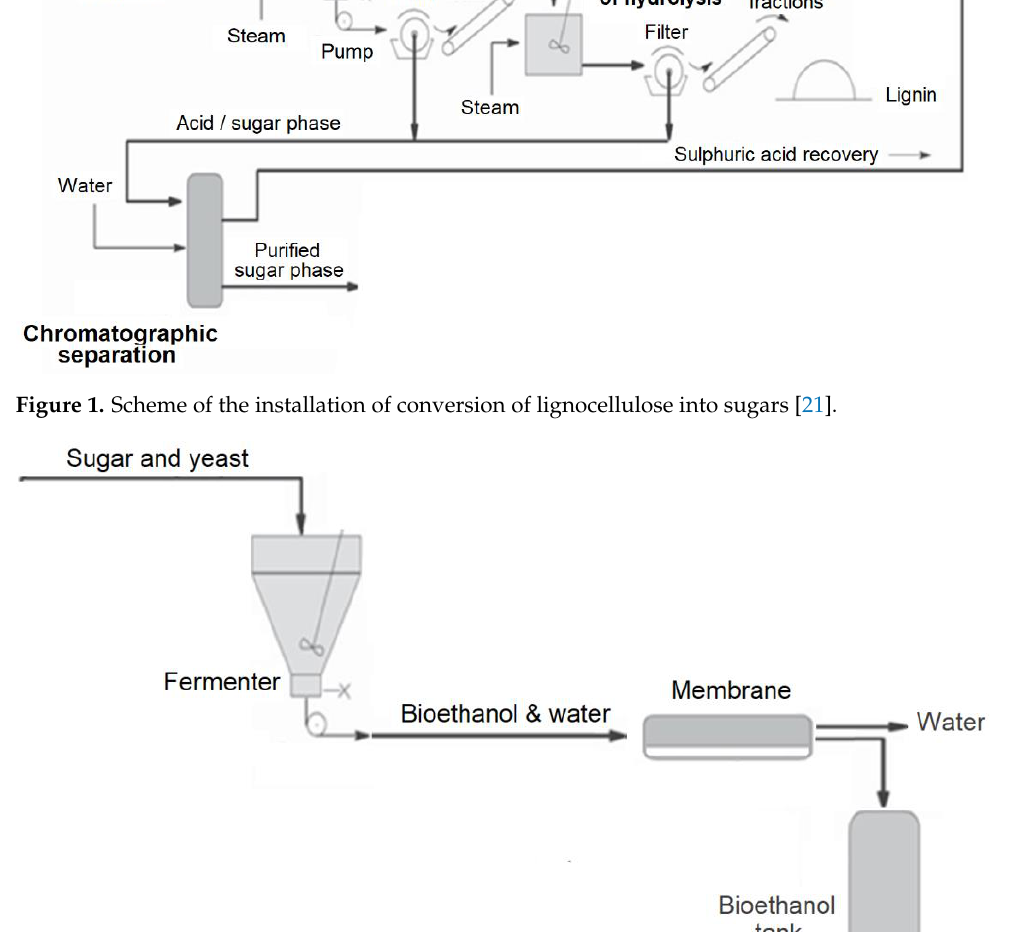
Figure 1. Scheme of the installation of conversion of lignocellulose into sugars [21].